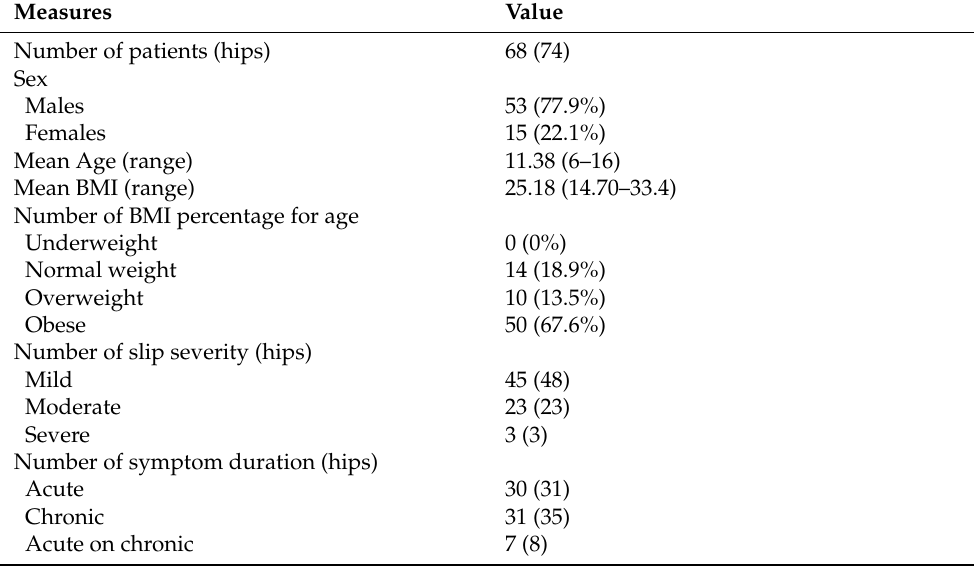
Table 1. Overall patient demographic data.